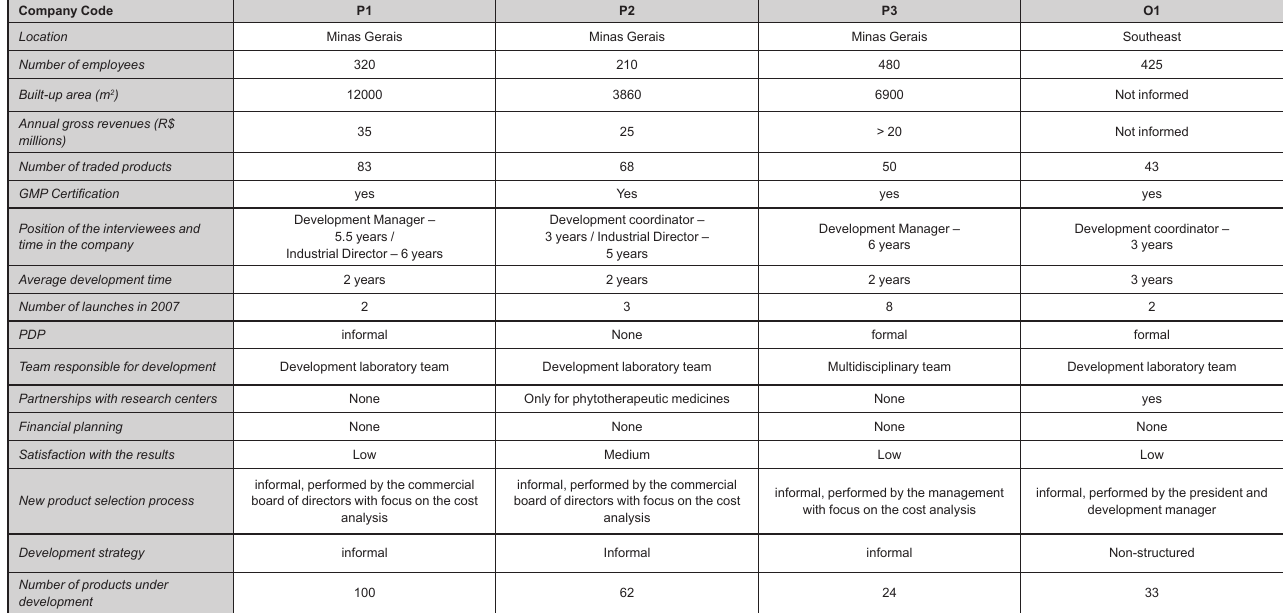
FIGURE 3 – Characteristics of the companies studied.